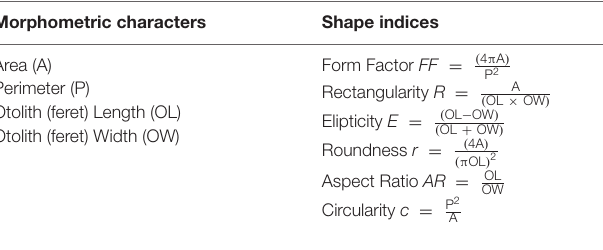
TABLE 1 | Commonly collected morphometric characters and calculated shape indices often included in outline